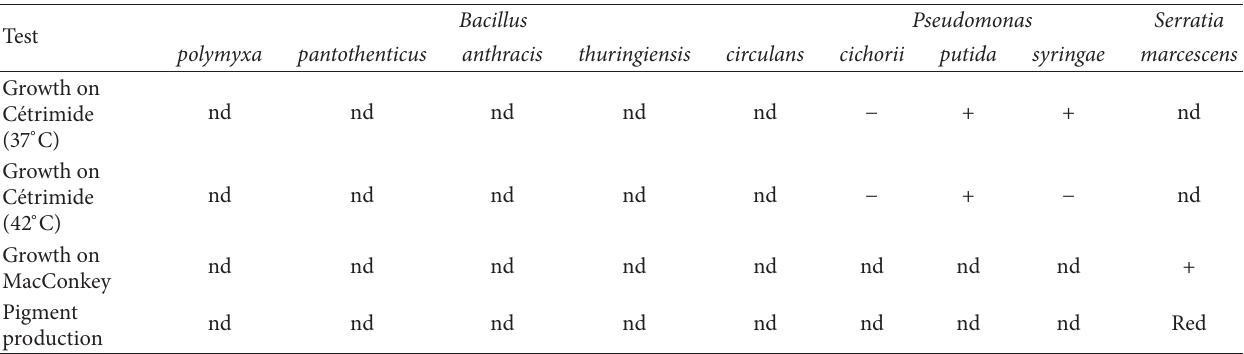
Table 3: Microbial production of NH 3 and HCN. Production of Production of Rhizobacteria HCN NH 3 (%) (%) Bacillus sp. 80 100 Pseudomonas sp. 77, 77 100 Serratia sp. 100